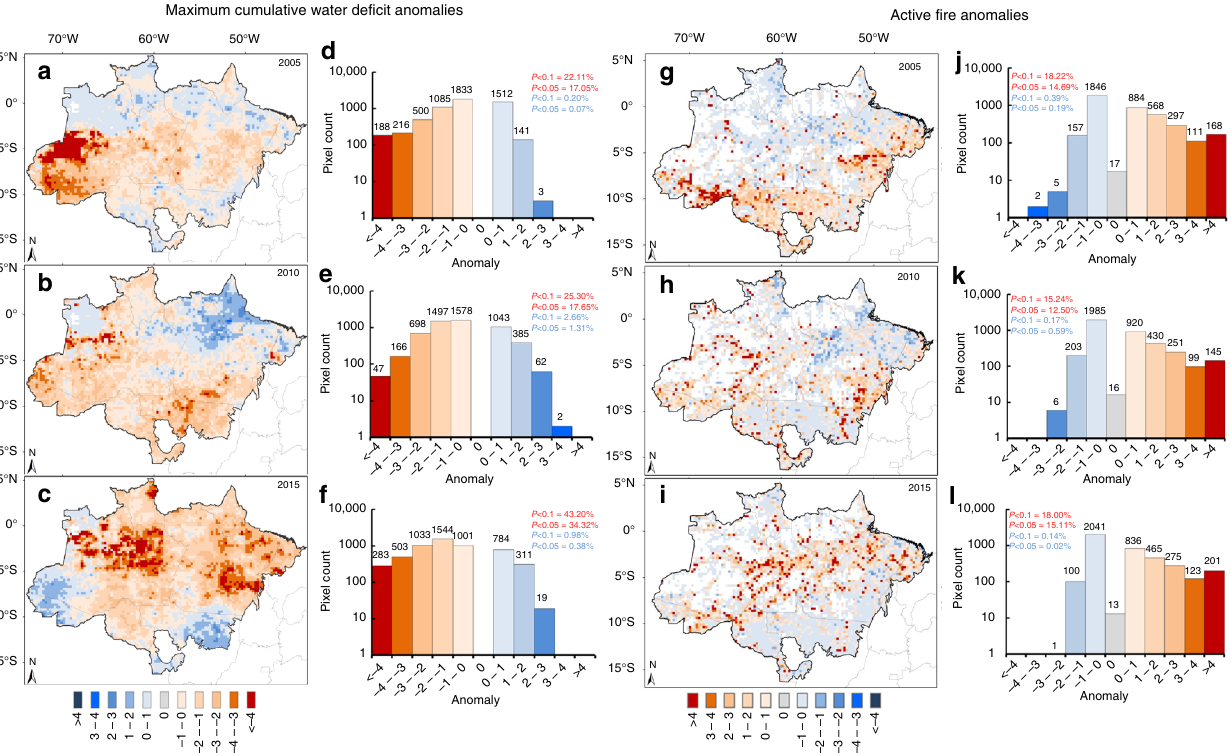
Fig. 3 Spatial patterns of water de fi cit and active fi re incidence in the Brazilian Amazon. Pixel-based annual anomalies ( σ ) of the Maximum Cumulative Water De fi cit (MCWD) for 2005 ( a) ), 2010 ( b ) and 2015 ( c ) and the histograms showing the pixel counts for each category in the MCWD map for 2005 ( d ), 2010 ( e ) and 2015 ( f ). Similarly, we show maps of active fi re anomalies for 2005 ( g ), 2010 ( h ) and 2015 ( i ) and their respective histograms ( j ), ( k ), ( l ). Red and blue bars indicate respectively positive and negative anomalies for fi res and the opposite for the MCWD. All units are standard deviation values calculated as the departure of annual values from the 2003 – 2015 annual averages, excluding drought years (2005, 2010 and 2015)